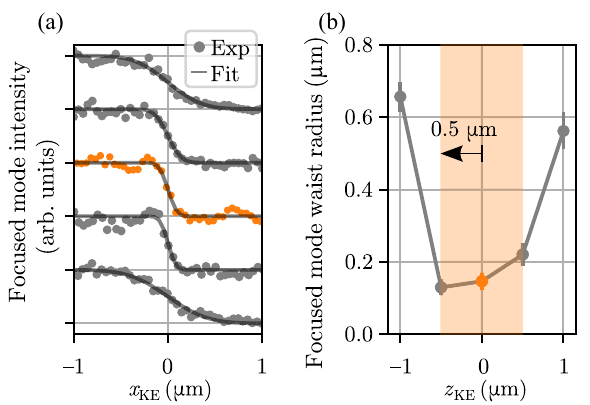
FIG. 3. (a) Knife-edge scans at various distances from the 0.35-NA zone plate relative to the focus position ( z (b) Fitted XUV waist radius as a function of z range is estimated to be 0 . 5 μ